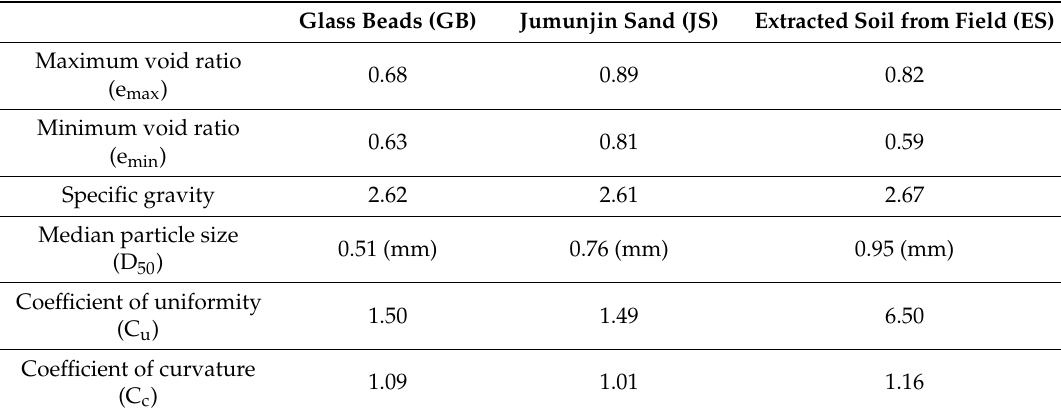
Table 1. Properties of glass beads, Jumunjin sand, and extracted soil from